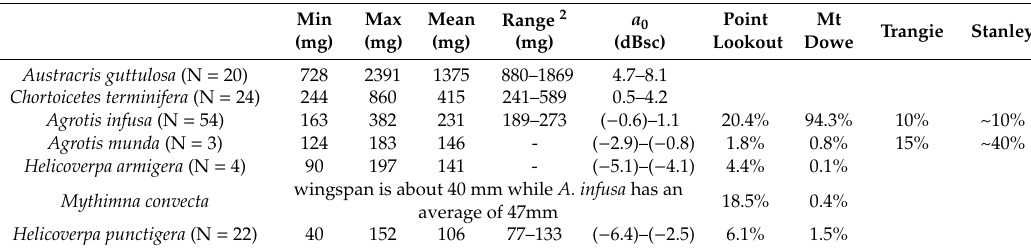
Table 4. The mass range 1 (mg) and estimated a 0 values (in dBsc) for candidate Australian insect species together with the percentage of total catch for each species caught in light traps at Point Lookout (30 ◦ 29 (cid:48) S, 152 ◦ 28 (cid:48) E) and Mt. Dowe (30 ◦ 17 (cid:48) S, 150 ◦ 10 (cid:48) E) NSW from 1985 to 1989 [18,31] and from aerial catches at Trangie, NSW (31 ◦ 59 (cid:48) S, 147 ◦ 57 (cid:48) E) in late September [17] and at Stanley, Tasmania (40 ◦ 46 (cid:48) S, 145 ◦ 17 (cid:48) E) during late September and early October 1973